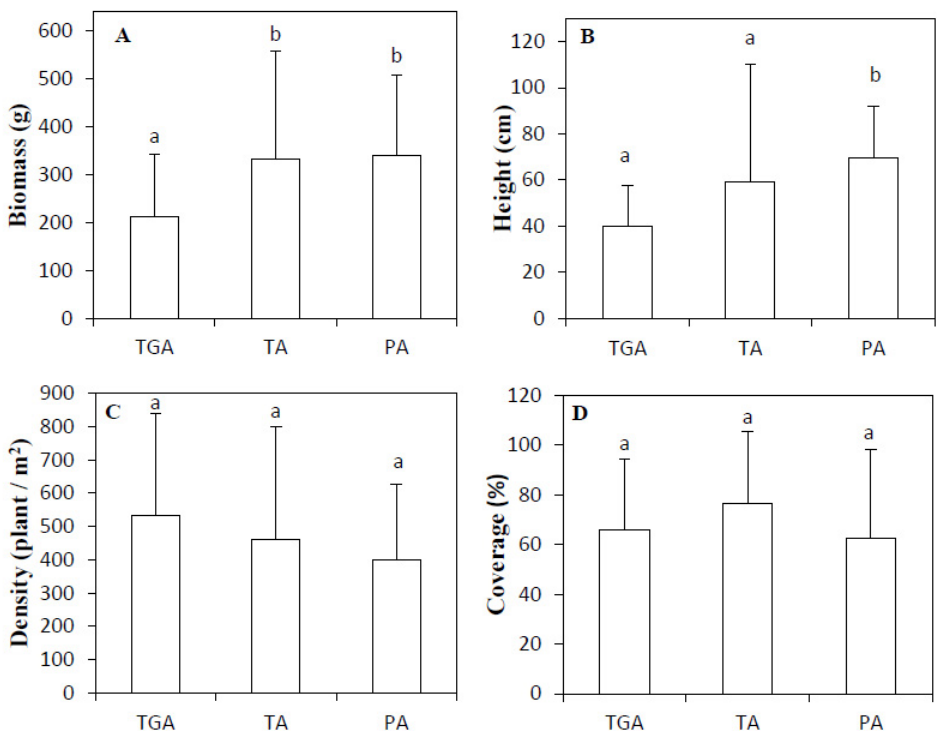
Figure 2. Variation (standard deviation) in biomass ( A ), height ( B ), density ( C ), and coverage ( D ) of plant communities at three sites subject to different levels of disturbance in the KGTA and YWNR, Beijing Municipality, China. Height of bars indicates mean values, and length of error bars indicates standard deviation. Per parameter, different letters indicate statistically significant differences between means ( p < 0.05).